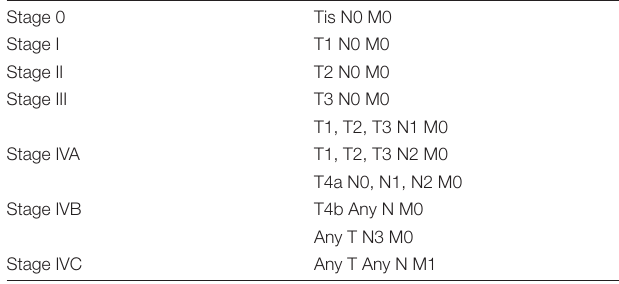
TABle 3 | TNM Stages for parotid cancer. TABle 4 | WHO histological classification of salivary gland tumors 2017 (42,